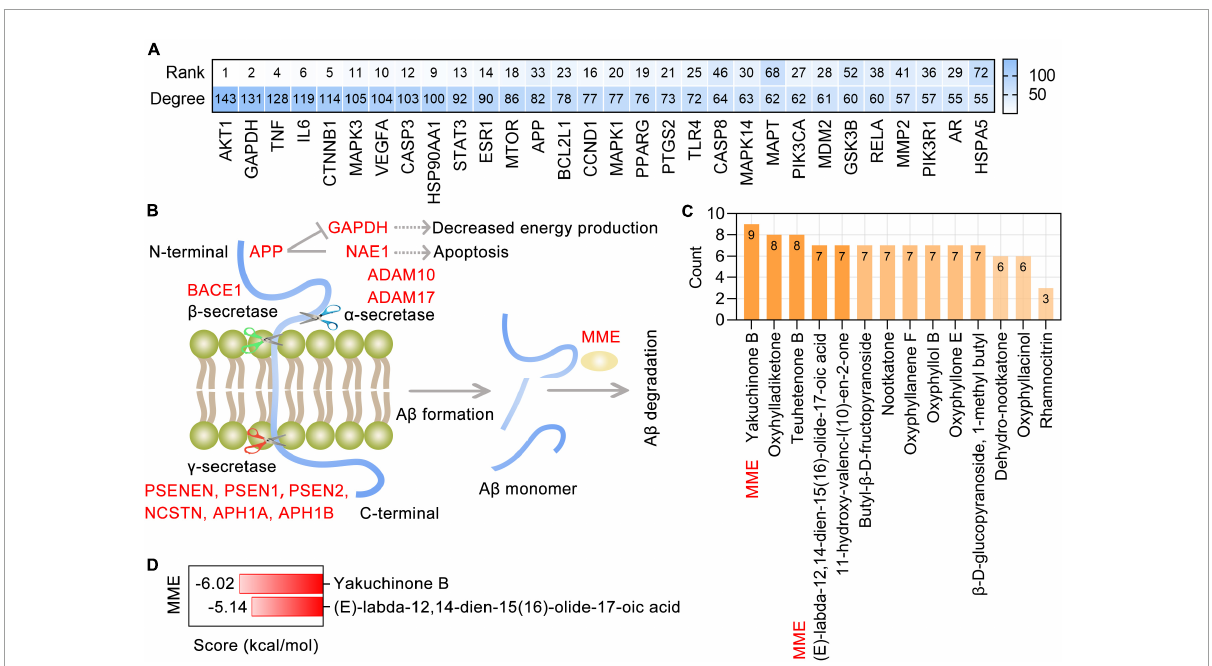
FIGURE5 Targeting AO targets associated with A β production and degradation. (A) Top 30 core targets of AO’s 282 anti-AD targets were ranked by degree, and the heatmap also shows the ranking of anti-AD core targets in the PPI network formed by all 662 targets of AO. (B) Schematic diagram of the A β production and A β degradation, with AO targets shown in red font. A β is produced by α -, β -, and γ -secretase-mediated cleavage of APP and efficiently degraded by MME. (C) AO phytochemicals involved in A β production and degradation ranked according to the numbers of targets. (D) Molecular docking of the yakuchinone B, (E)-labda-12,14-dien-15(16)-olide-17-oic acid with MME, which is one of the most prominent A β -degrading